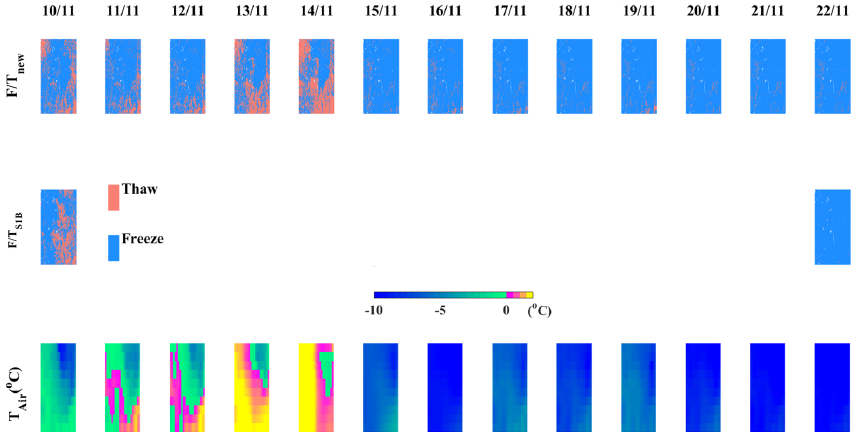
Figure 14. Same as Figure 13 but over the Saihanba area from 10 November 2019 to 22 November 2019.